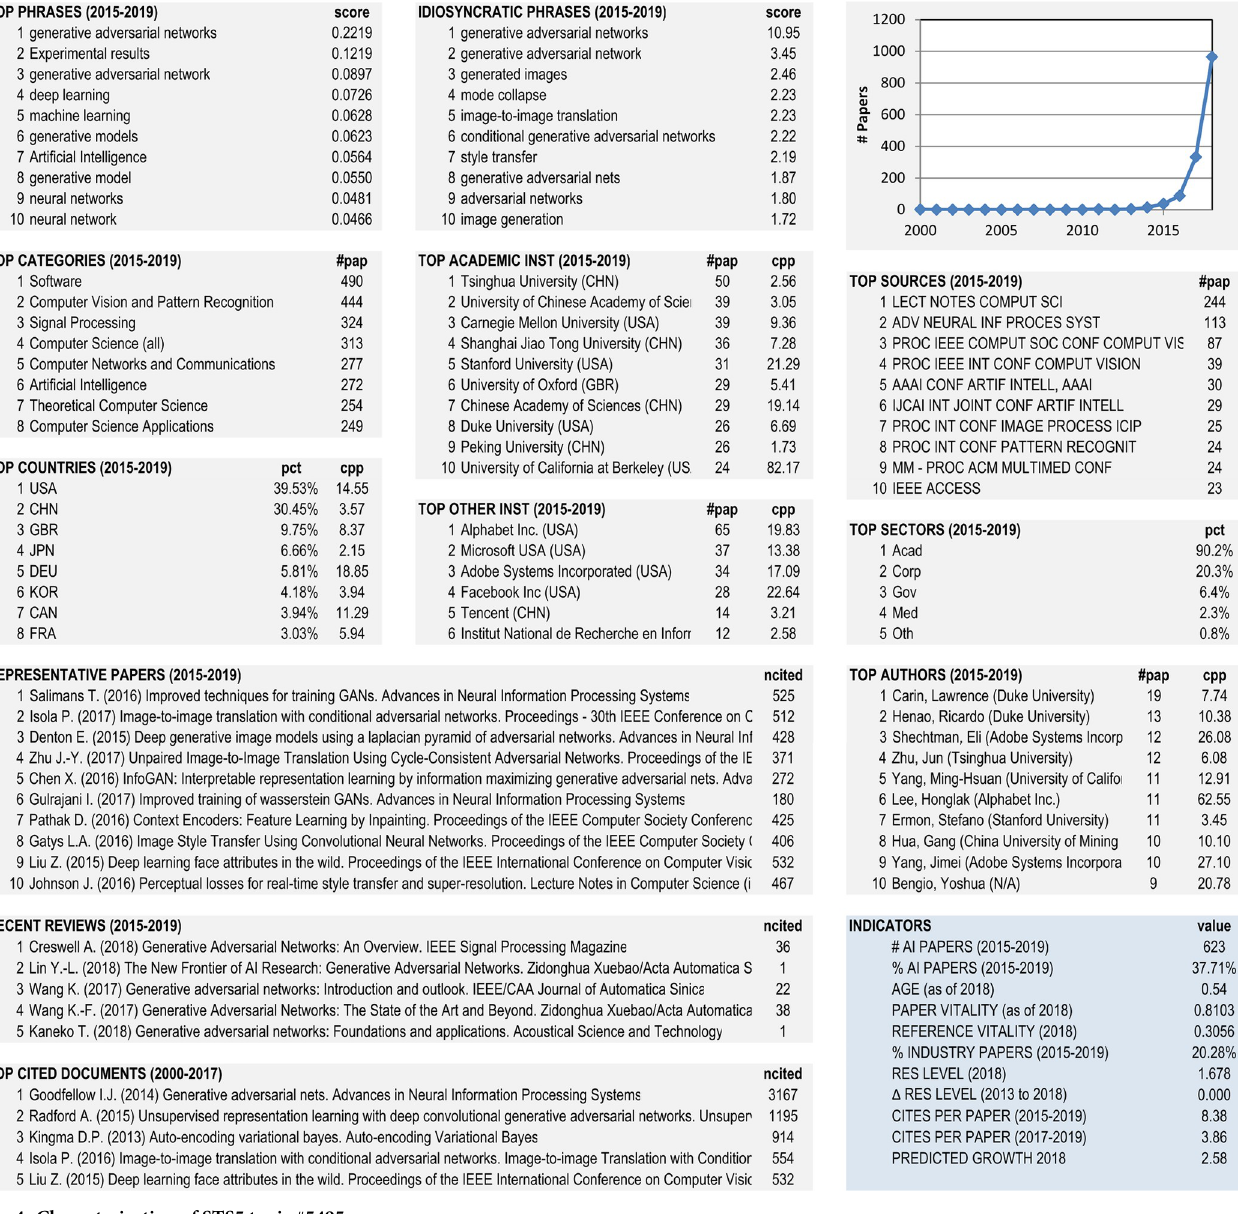
Fig 4. Characterization of STS5 topic